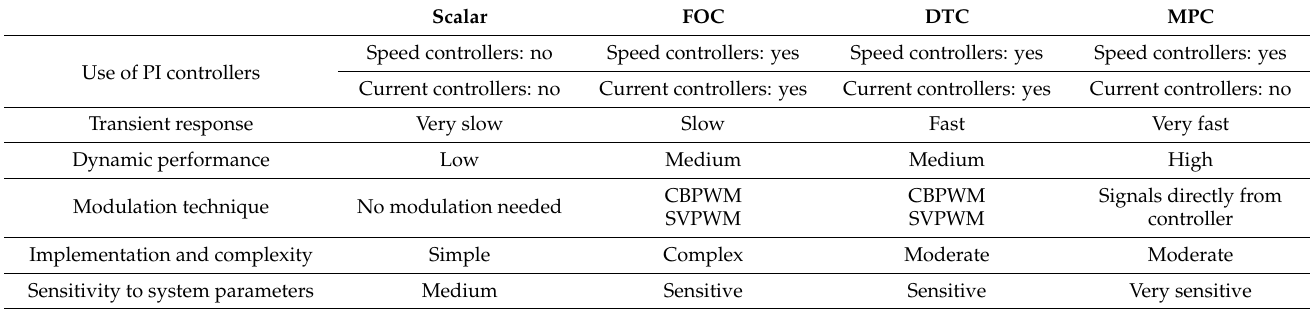
Table 4. Comparison between different control methods.